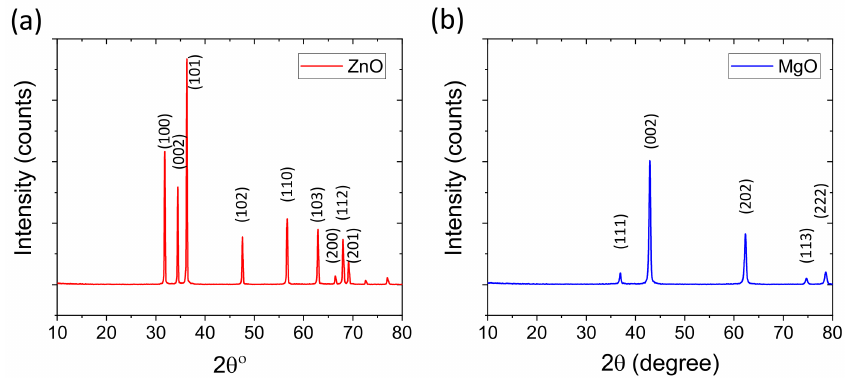
Figure 1. XRD plots of used cure activators; ( a ) ZnO and ( b ) MgO.